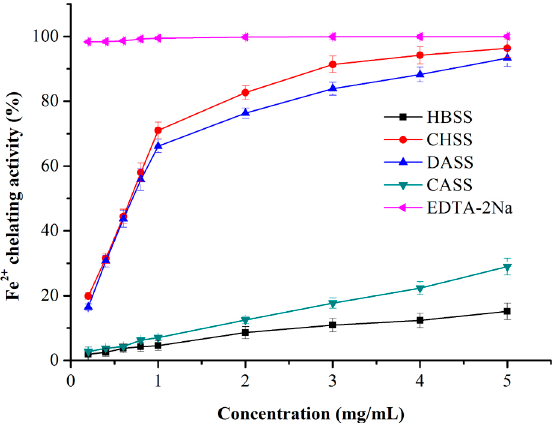
Figure 6. Iron (Fe 2+ )-chelating activity of MLPs at different concentrations.